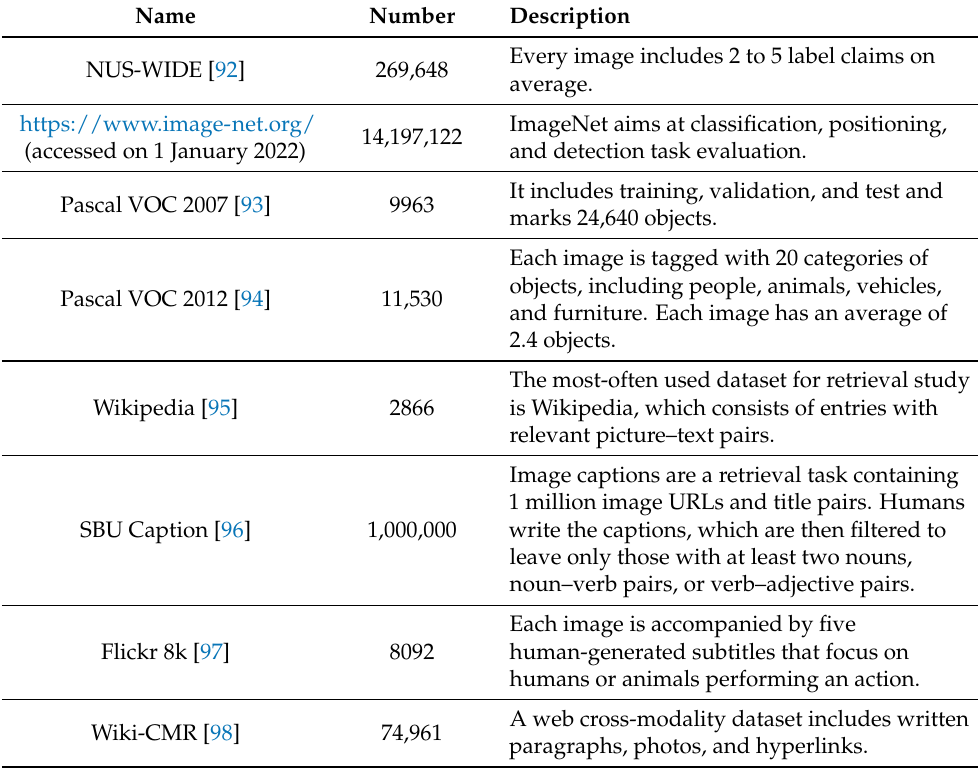
Table 4. Summary of representative datasets facilitating cross-modal